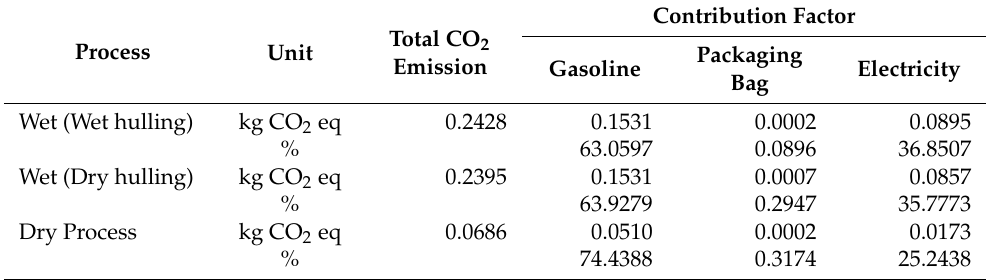
Table 3. Emission contributor factors.